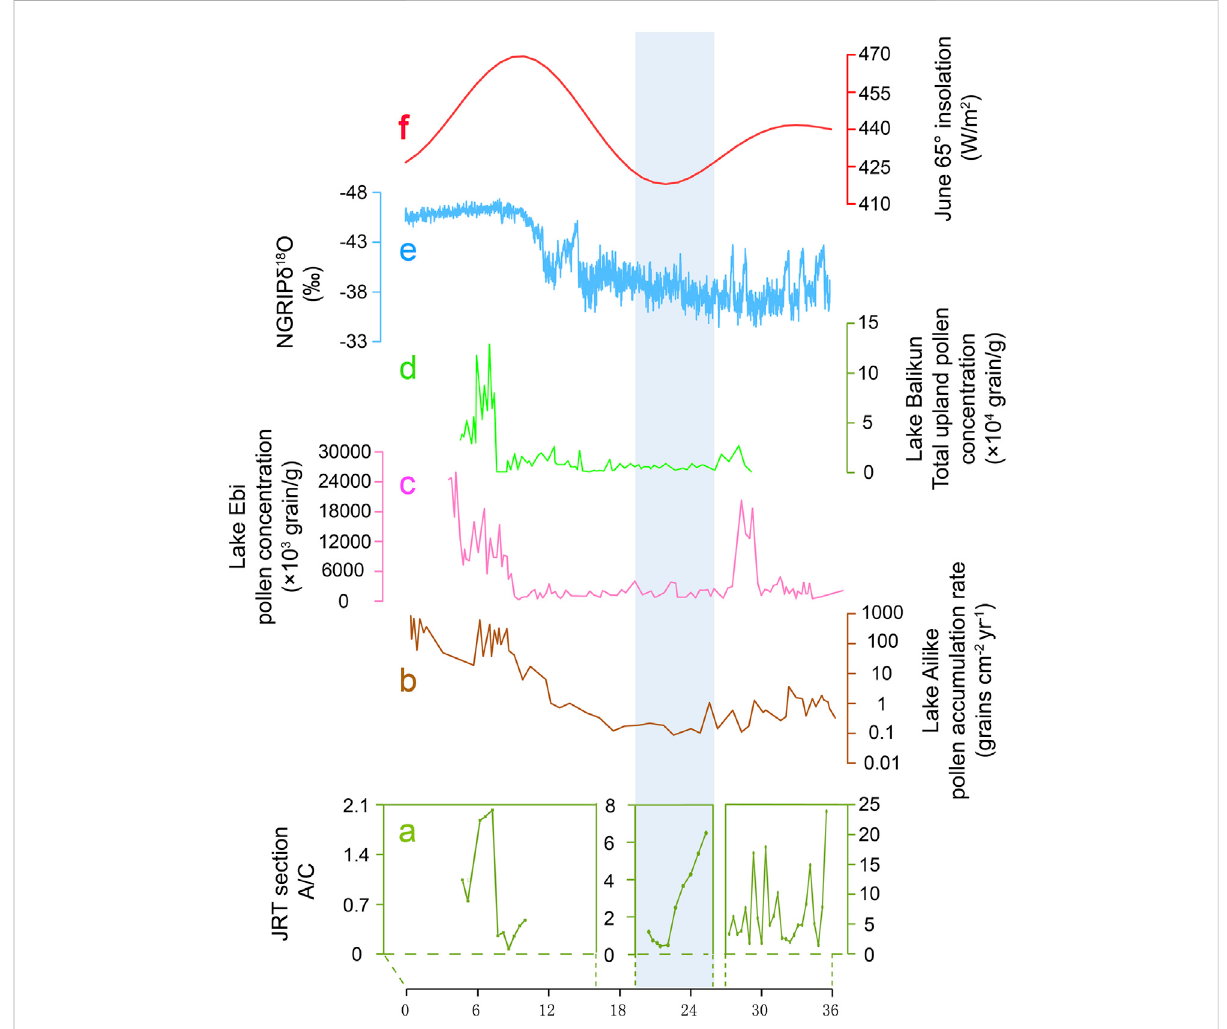
FIGURE 5 ComparisonofthevegetationconditionobtainedfromsedimentfossilpollenreconstructionwithclimaterecordsintheACA. (A) A/CoftheJRT section; (B) PollenaccumulationrateofLakeAilike(ChenandLiu,2022); (C) PollenconcentrationofLakeEbi(Jiaetal.,2020); (D) Totaluploadpollen concentration of Lake Balikun (Tao et al., 2010; Zhao et al., 2015); (E) Greenland NGRIP δ 18 O record on GICC053 1.0063 chronology (WAIS Divide Project Members, 2015); (F) Solar insolation at 65 ° N for July (Berger and Loutre, 1991). The blue bar represents the time of the LGM (Clark et al., 2009); The X-axis of the data from the JRT section uses a dashed line, which only represents that the corresponding data exists in an approximate time